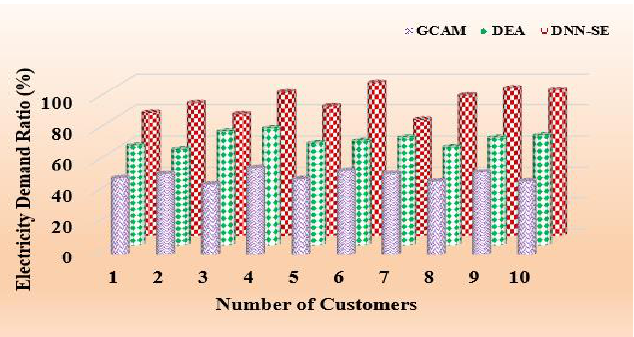
Figure 8. Electricity demand ratio.